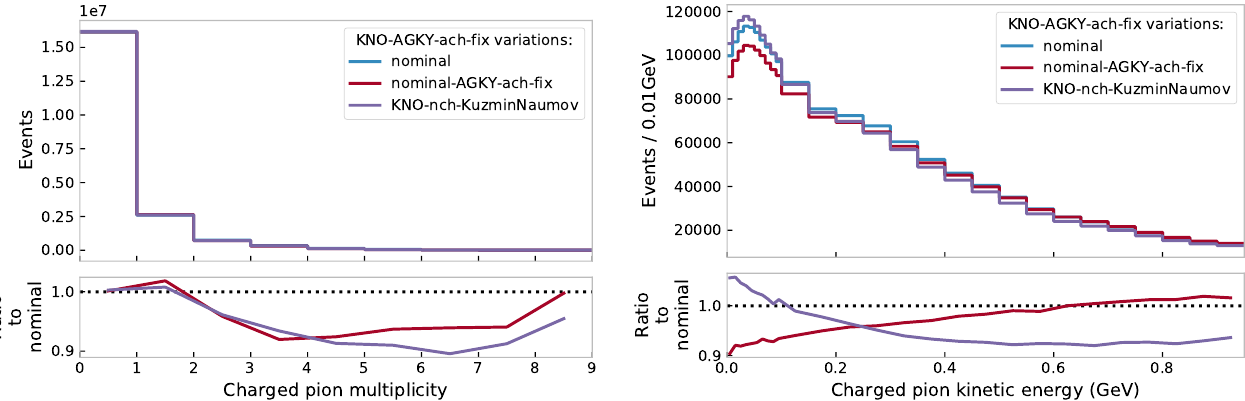
Figure 145. GENIE predictions for charged pion multiplicity ( left ) and kinetic energy ( right ) in the total CC ν µ inclusive sample using the variations on AGKY’s